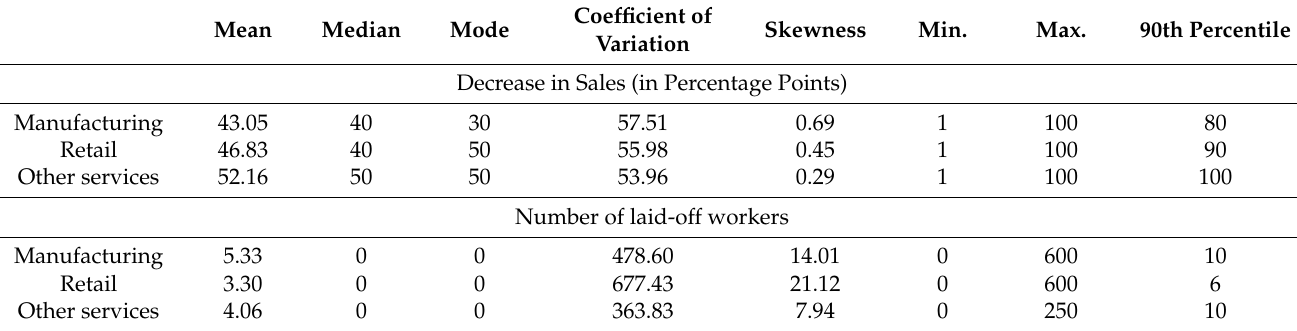
Table 3. Percentage of companies that remained open or were temporarily or permanently